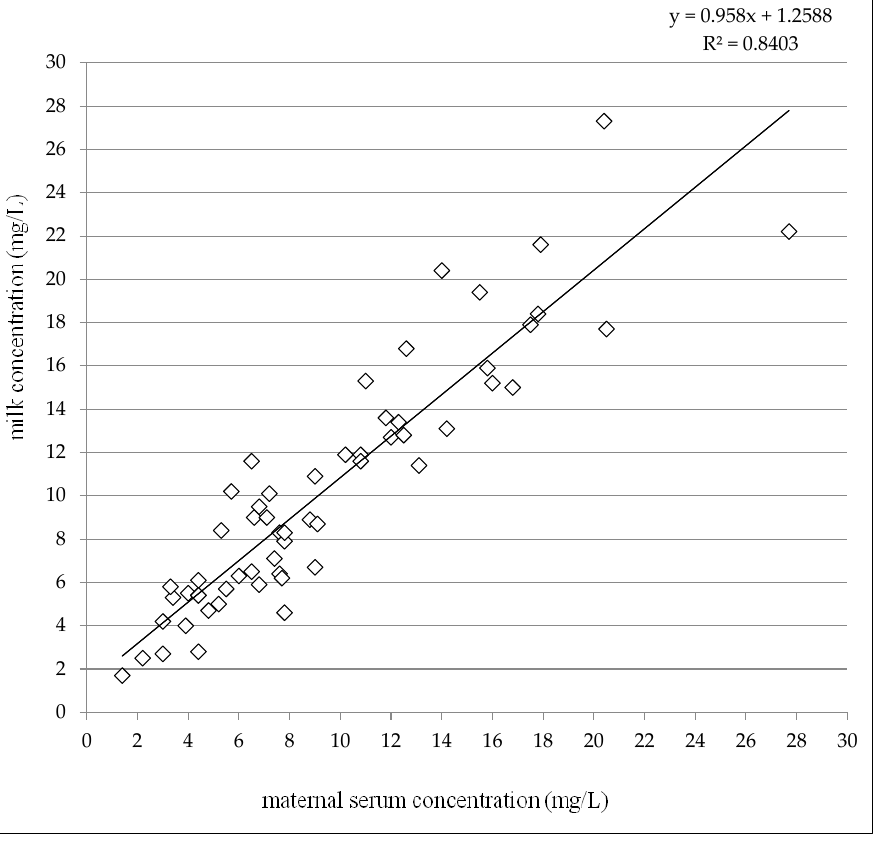
Figure 4. Correlation between milk concentrations and maternal serum concentrations of levetiracetam 2–31 days after delivery altogether. N = 58, p < 0.0001, the Spearman correlation coefficient = 0.9110.